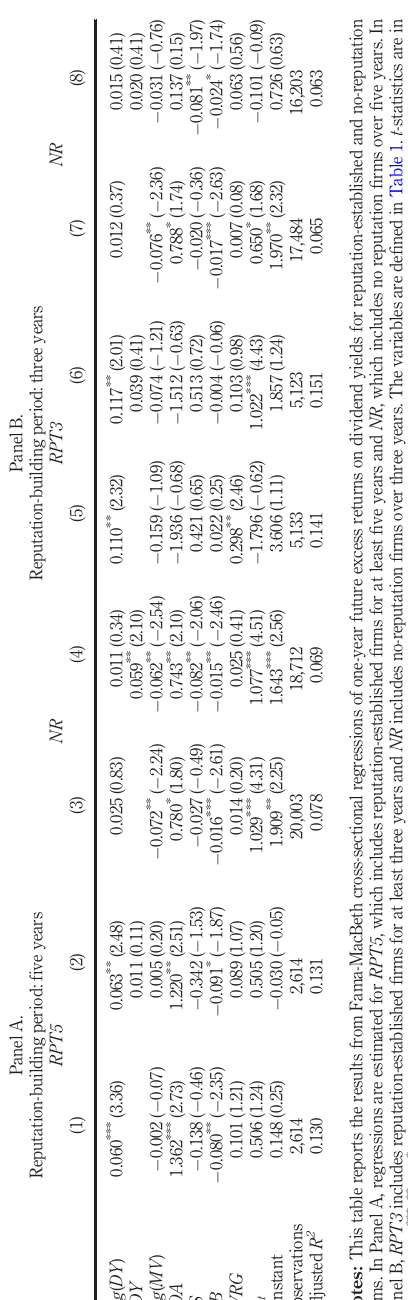
Table 10. Relation between stock returns and dividend yields for reputation and no reputation groups: Fama-MacBeth cross-sectional